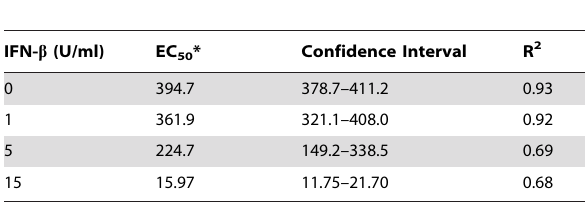
Table 2 . Idarubicin effect on ISRE activity relative to IFN- b treatment